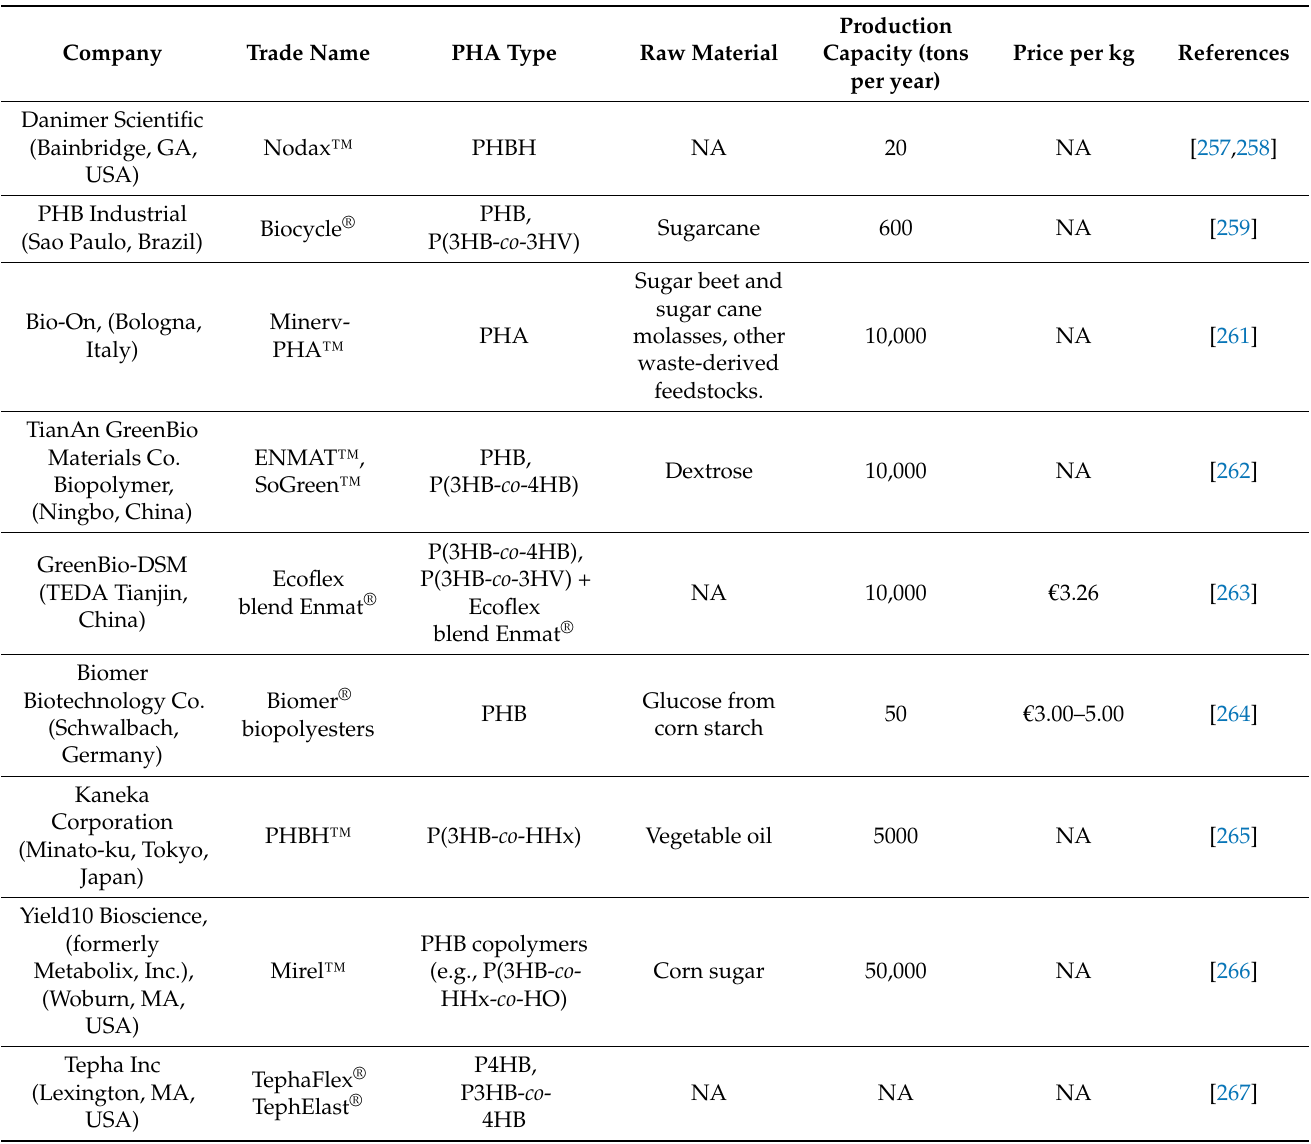
Table 7. Pilot and industrial-scale PHA manufacturers currently active